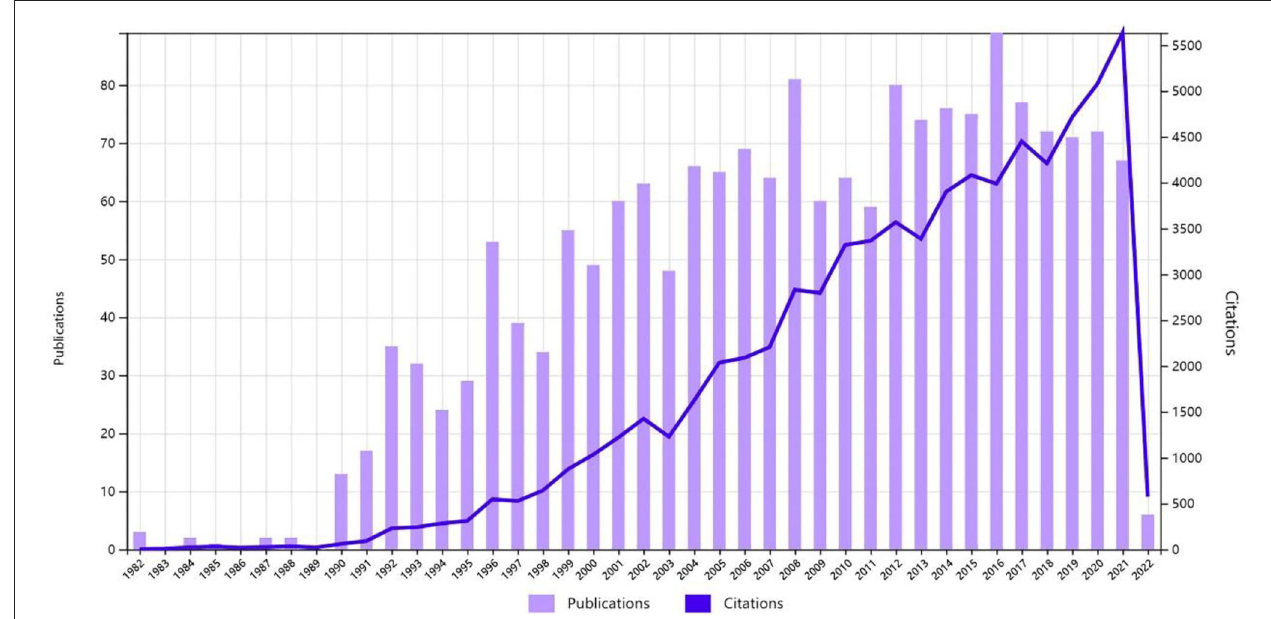
FIGURE 1 | The distribution depicts years of publication, and the number of citations